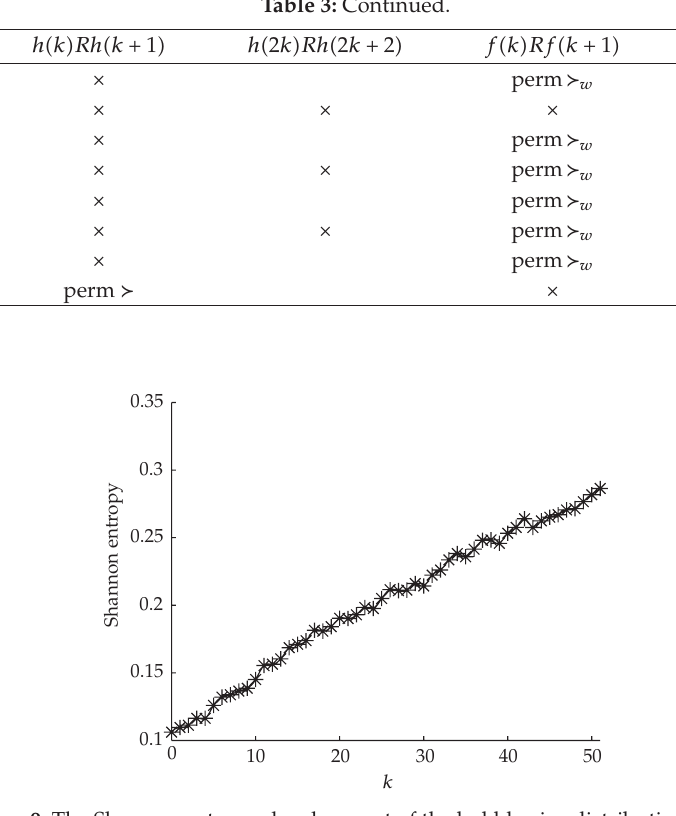
Figure 9: The Shannon entropy development of the bubble-size distribution set H